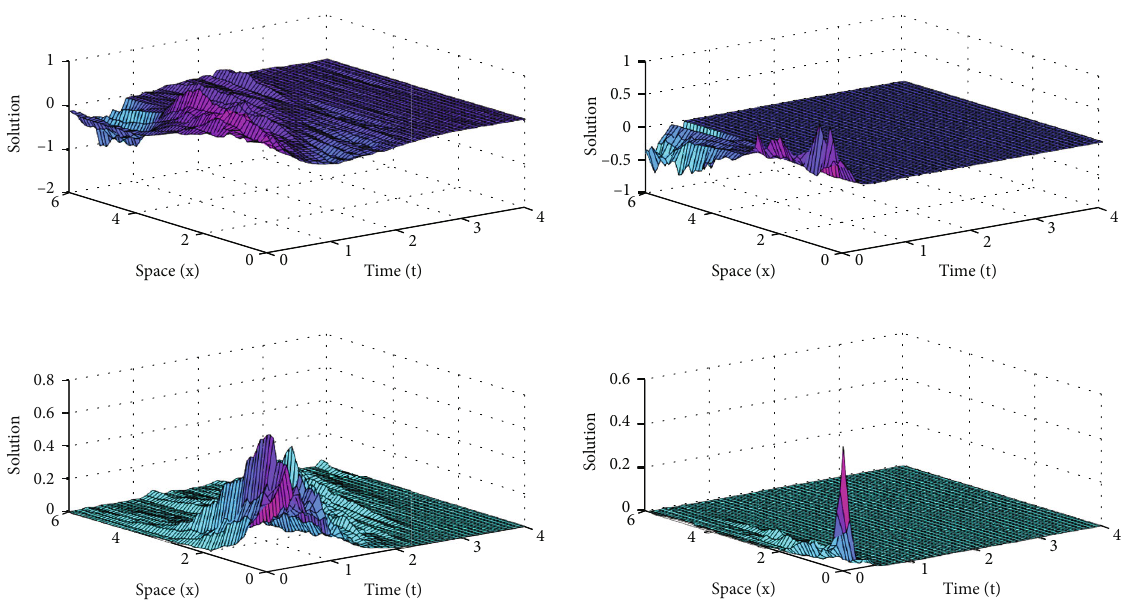
Figure 2: 3D diagram of Equations (25) and (45) with σ = 1, 2